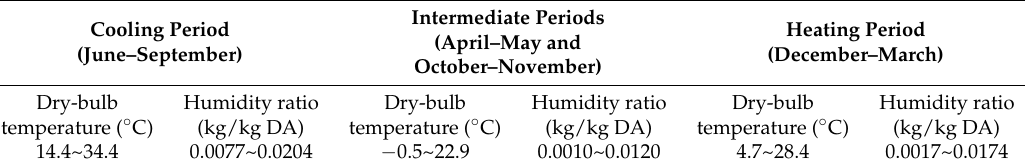
Figure 2. Annual outdoor dry ‐ bulb temperature and humidity ratio of Tokyo. DA, dry air. Table 3. Range of outdoor dry ‐ bulb temperature and humidity ratio in each period.